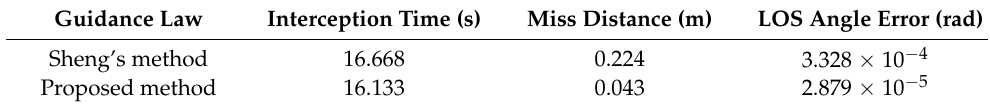
Table 6. Interception times, miss distances, and LOS angle errors of two guidance laws with α = 0.07. Guidance Law